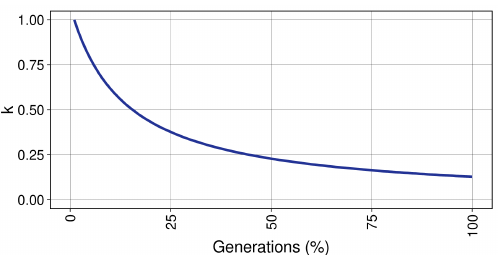
Figure 6. Evolution of the values of k during the execution of the EA.